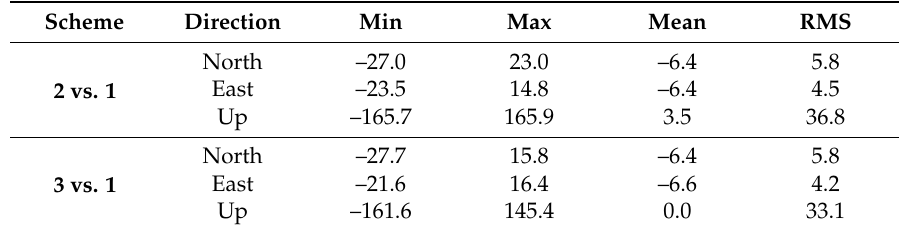
resp. 3 , and the corresponding results from Scheme 1 (Unit: